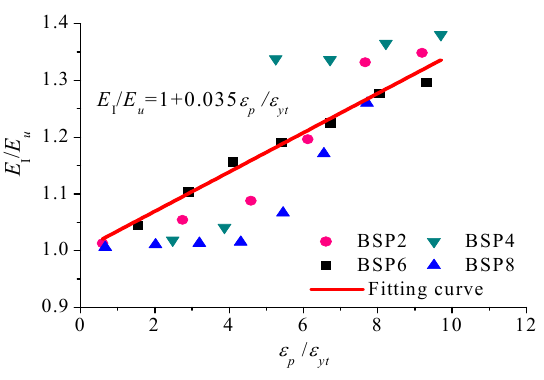
Figure 14. Degradation rule of the unloading modulus.